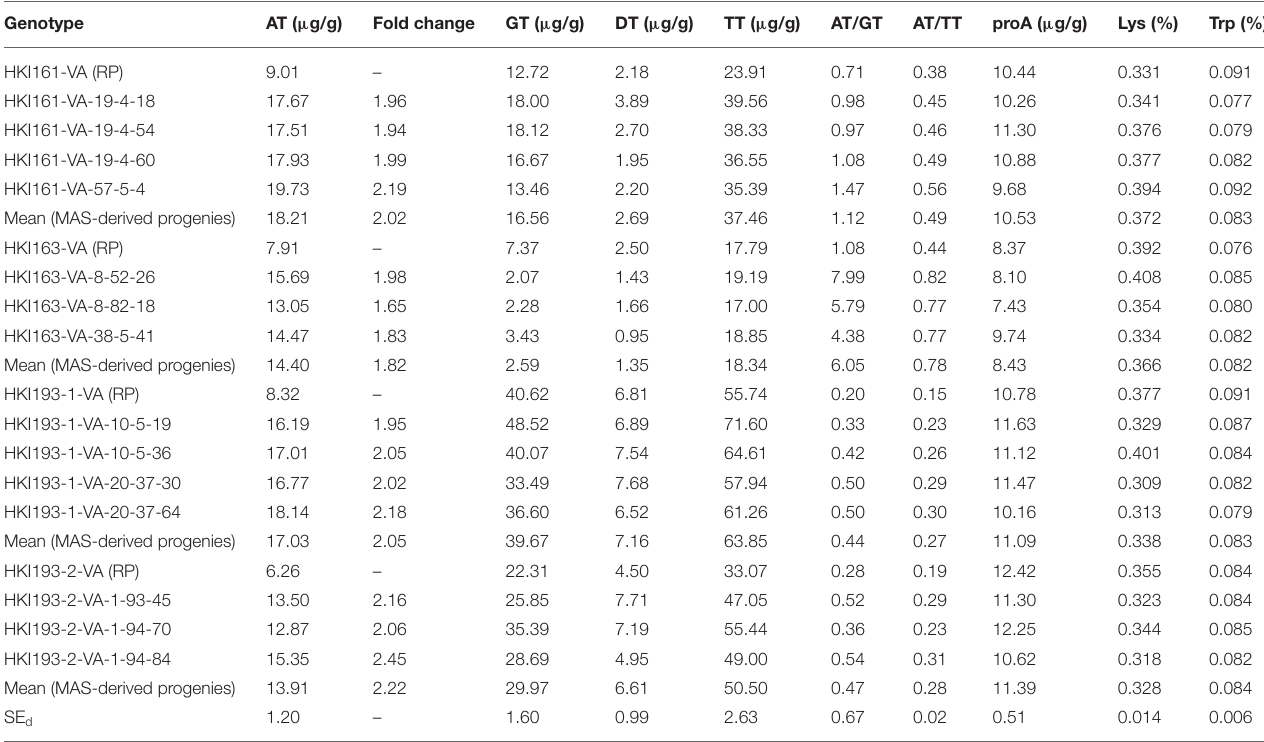
TABLE 3 | Mean performance of vte4 introgressed progenies and their recurrent parents for different quality parameters.